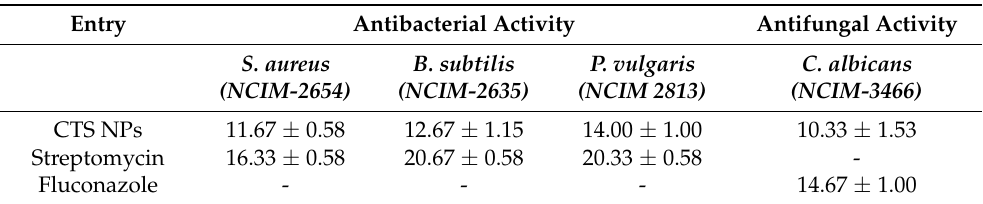
Figure 8. ( a ) Zone of inhibition: (1) CTS NPs + DMSO, (2) DMSO, (3) CTS + H 2 O, (4) H 2 O, and (5) antibiotic. ( b ) The statistical analysis of CTS NPs against tested microbial and fungal organisms. Table 2. The zone of inhibition of three bacterial strains. S. aureus, B. subtilis, P. vulgaris and one fungal strain, C. albicans